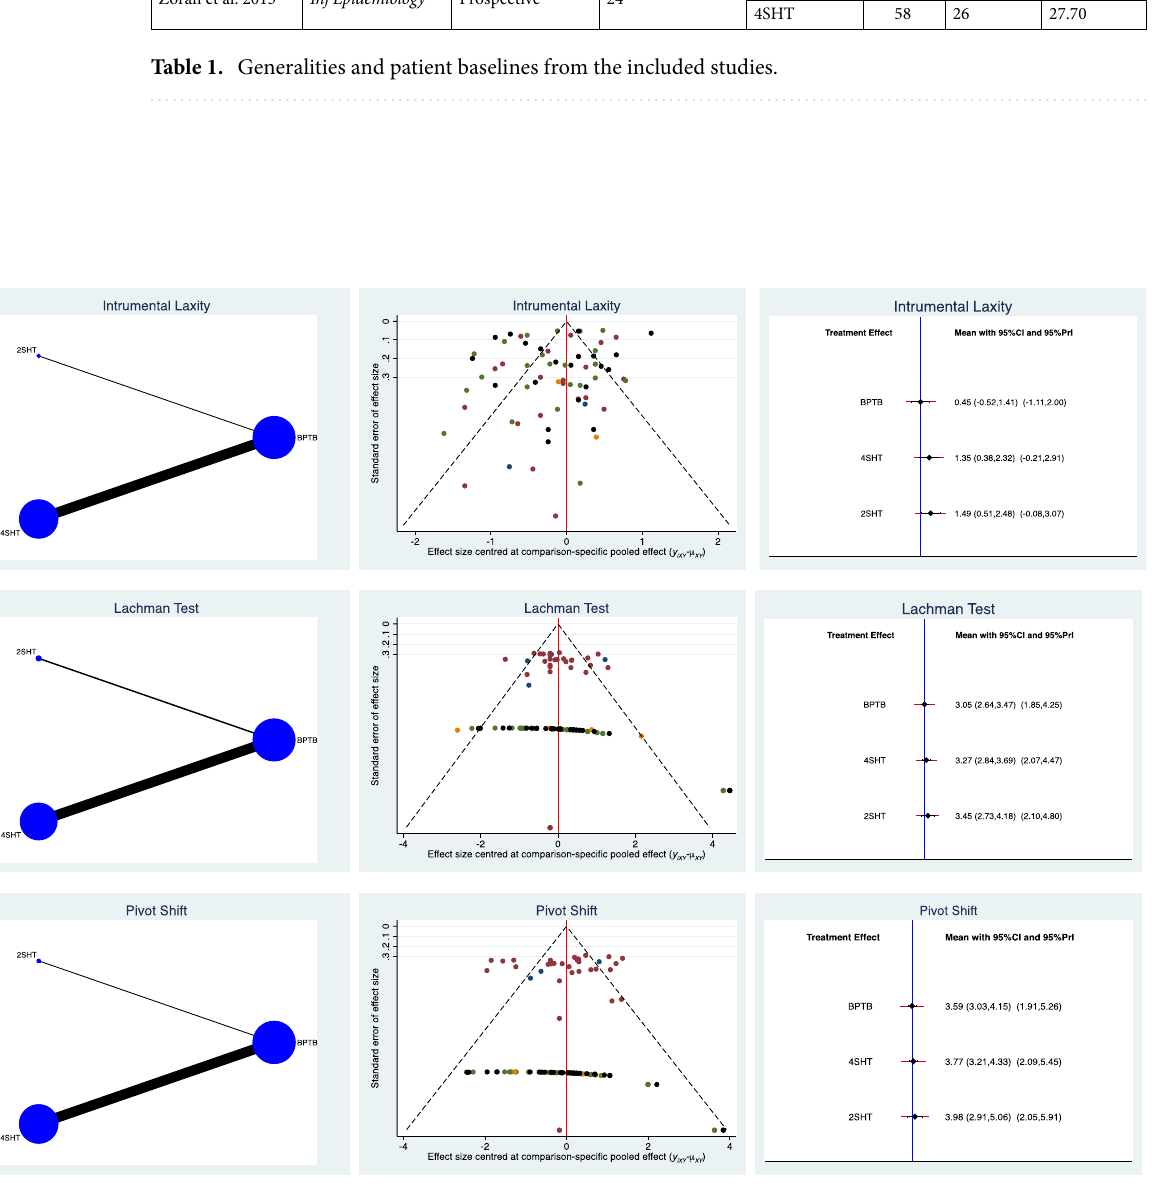
Figure 3. Edge, funnel, and interval plots of the network comparisons: joint